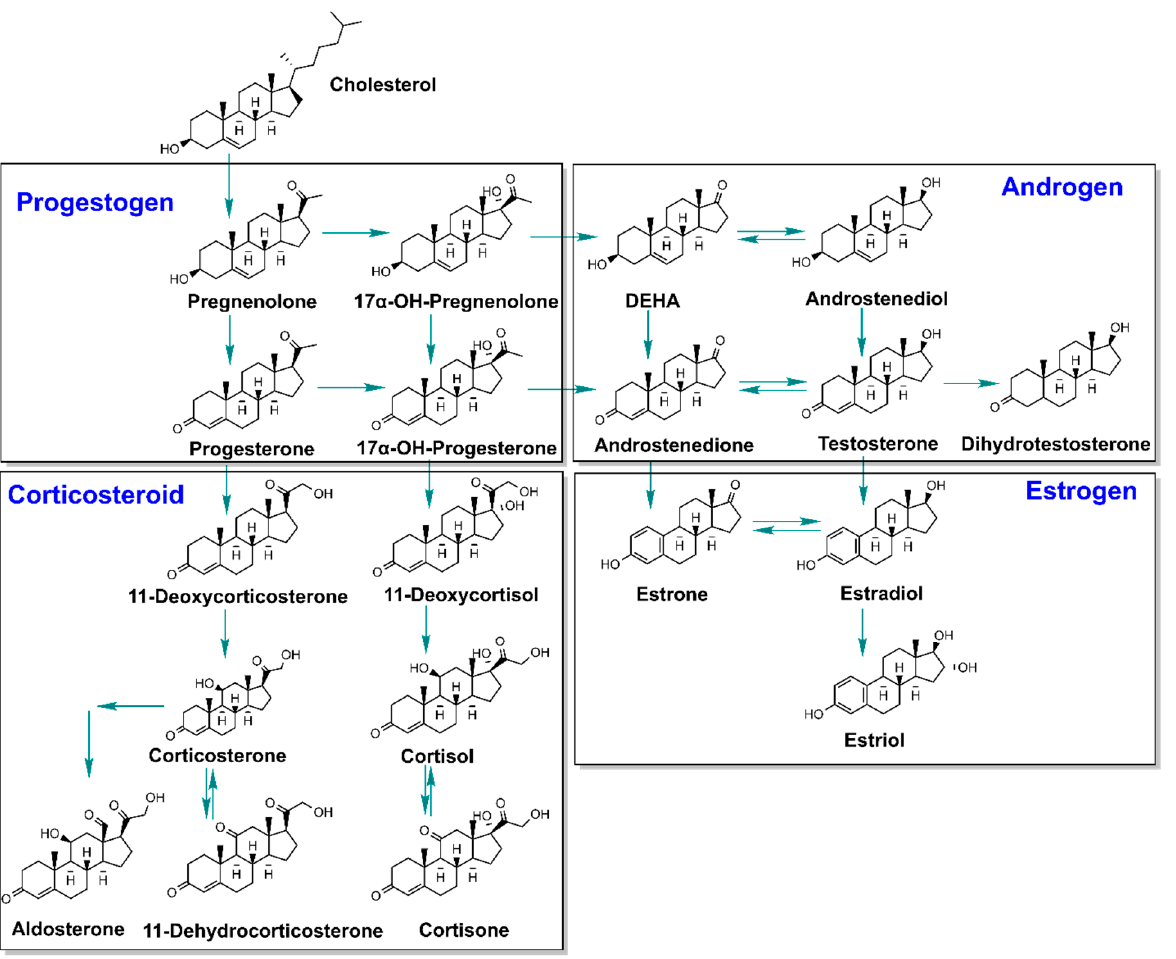
Figure 1. Molecular structures and metabolic pathway of the 19 steroid hormones investigated in this study.